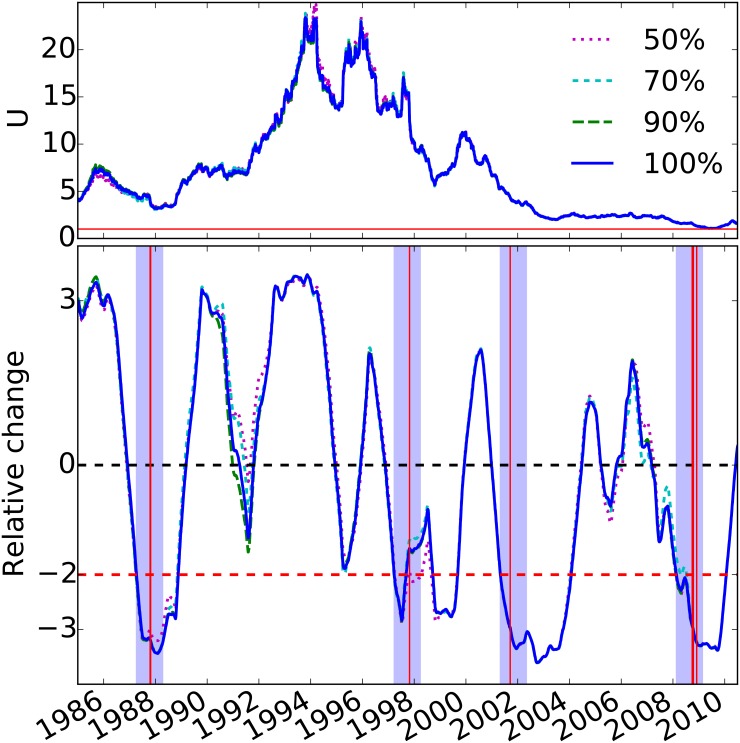
Model parameter (top panel) and relative change (bottom panel) in model parameter U for the period 1985–2010, for varying subsamples of stocks.Similar to that of the top panel of Fig 3, but for different subsamples of stocks of 50%, 70%, 90%, and 100% of the entire sample used in Fig 3. Positive-return distributions are computed from the daily returns of stocks included in the corresponding subsamples. The original analysis is robust, with four true positives, i.e., no false positives or negatives, for the 70%, 90%, and 100% subsamples. One false positive is introduced for the 50% subsample due to the reduced sample sizes.